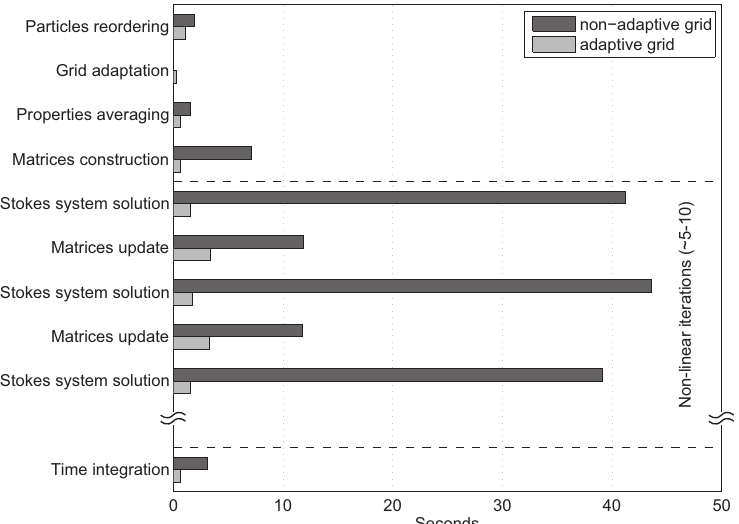
Figure 27. Performance comparison between adaptive and non-adaptive numerical schemes for brittle extension model. Dual AMD Opteron 8380 system was used.